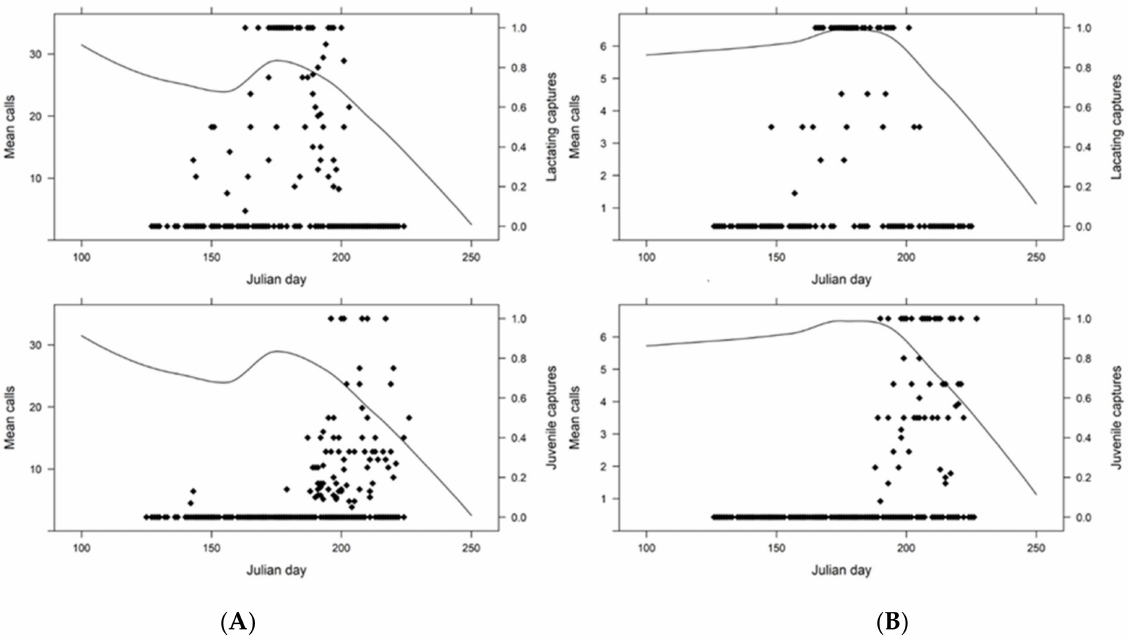
Figure 3. Proportion of juveniles and lactating females (black diamonds, right axis) within each sample and locally estimated scatterplot smoothing lines based on mean calls by Julian day (line, left axis) for ( A ) big brown bats ( Eptesicus fuscus ; EPFU) and ( B ) eastern red bats ( Lasiurus borealis ; LABO) within the mid-Atlantic region from 2015 to 2018. Black diamonds reflect each sample where the proportion of lactating female or juvenile bats was